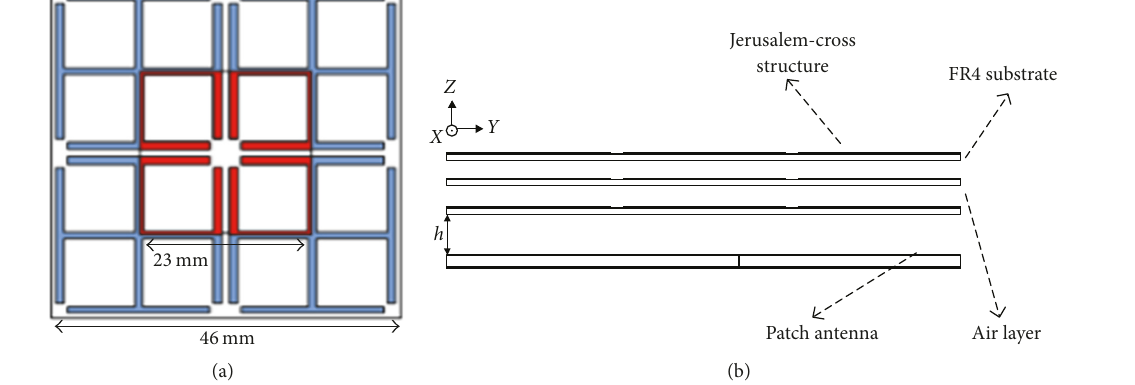
Figure 10: (a) Jerusalem-cross structure; (b) configuration of metamaterial radome and antenna